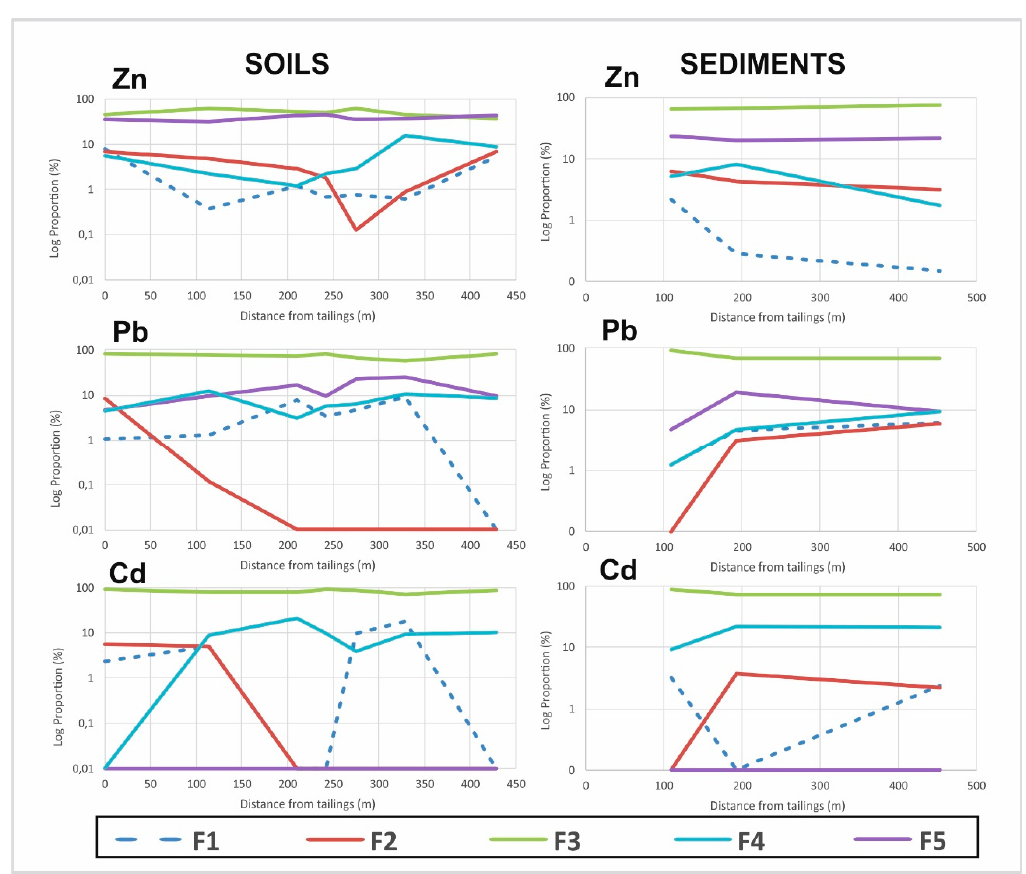
Figure 5. Evolution of the phase fractionation along the longitudinal transects. The limit of the tailings is taken as the starting point. F—fractions extracted (F1, F2, F3, F4 and F5).